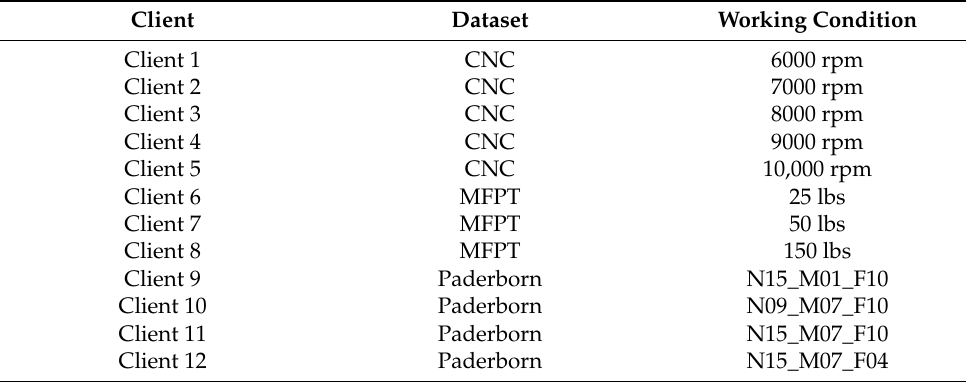
Table 3. Client dataset and test task